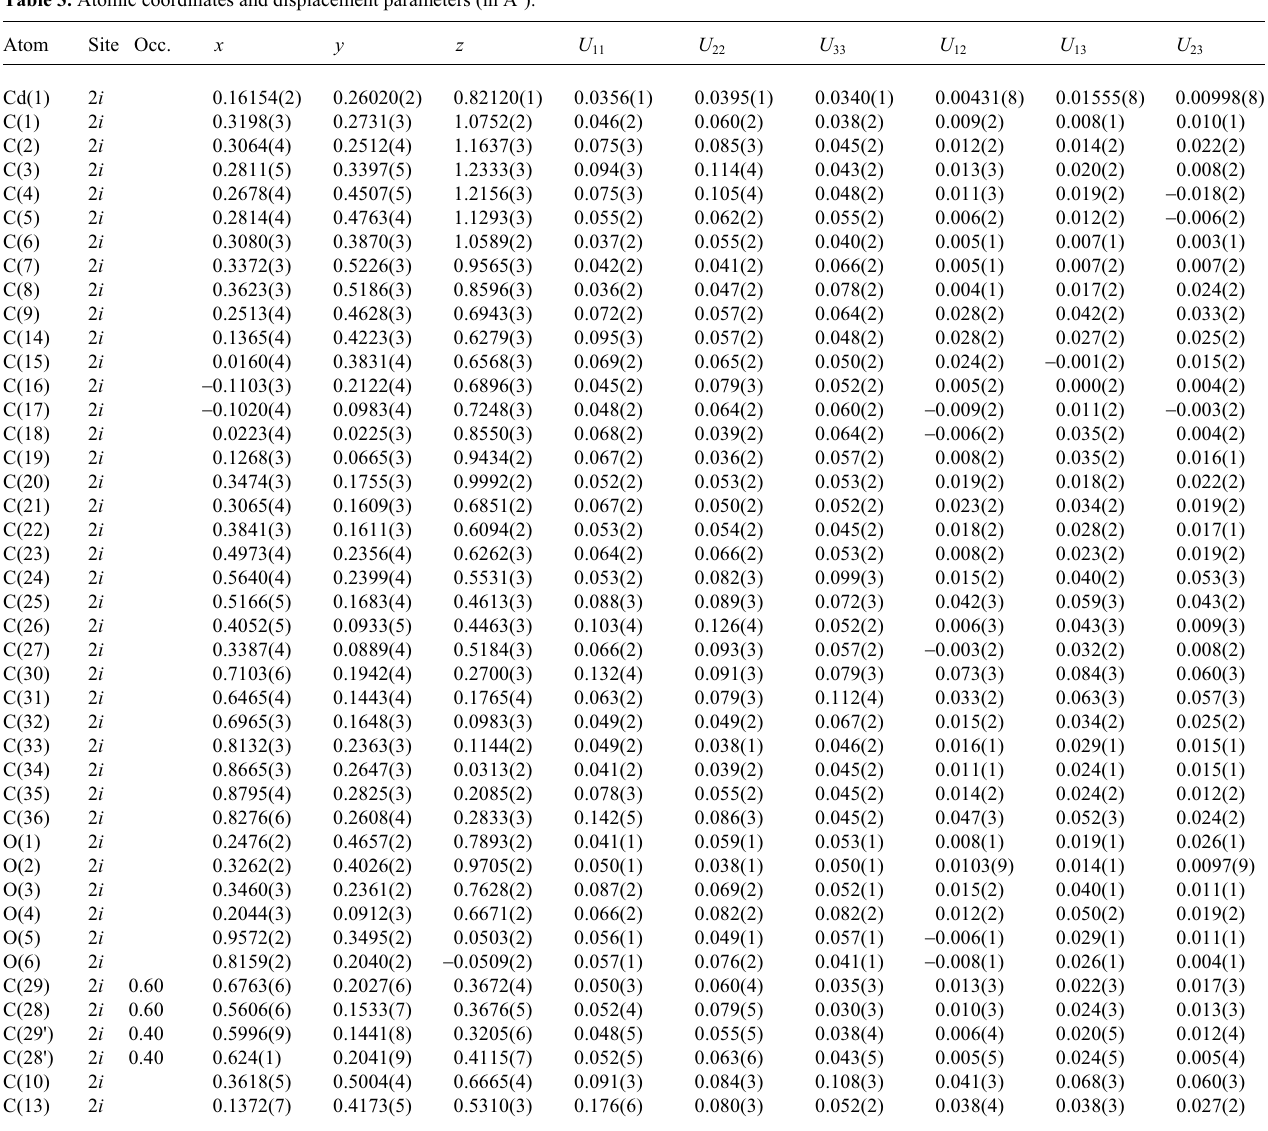
Table 3. Atomic coordinates and displacement parameters (in Å 2 ).